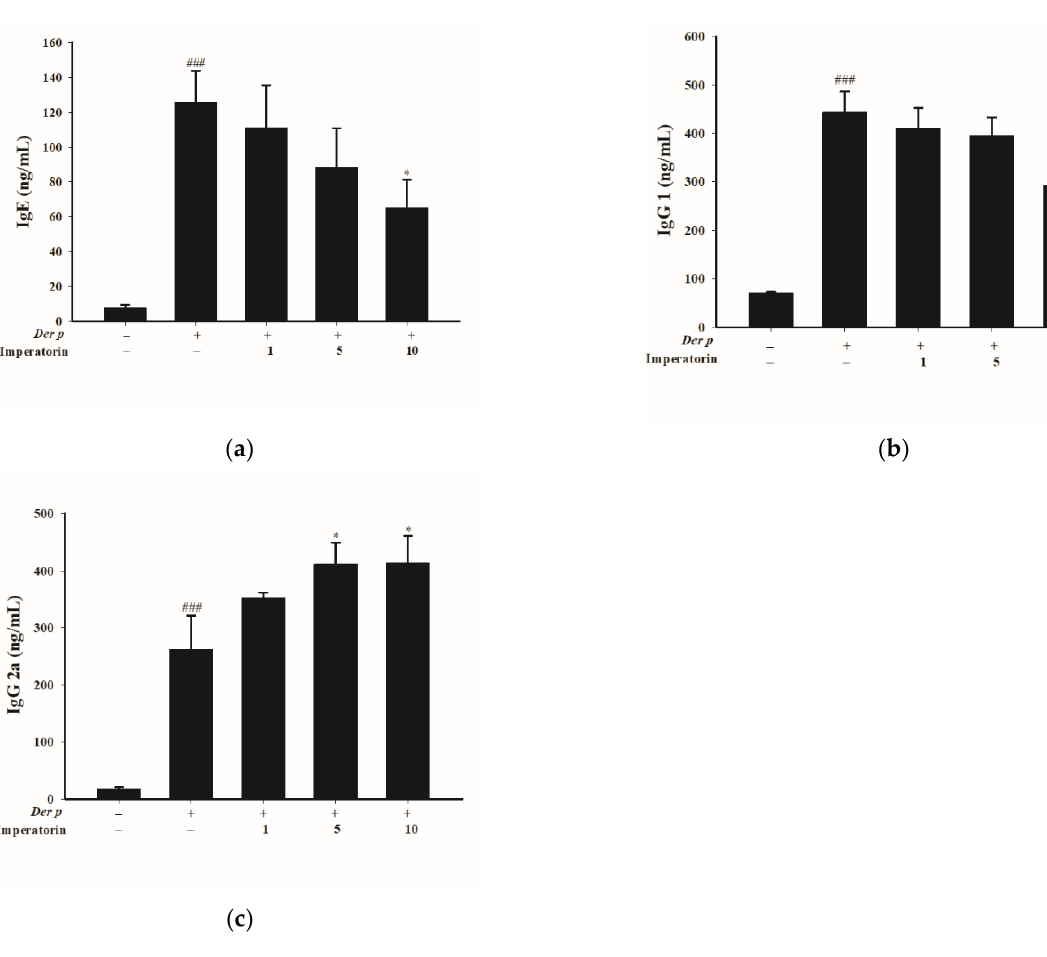
Figure 2. Effects of imperatorin on IgE, IgG1, and IgG2a expression in serum of mice with Der p -induced asthma. ### p < 0.001 compared with the control group, * p < 0.05 compared with Der p -induced group, n = 8 (one-way ANOVA followed by Scheffe’s multiple range test). All data are presented as the mean ± SEM.